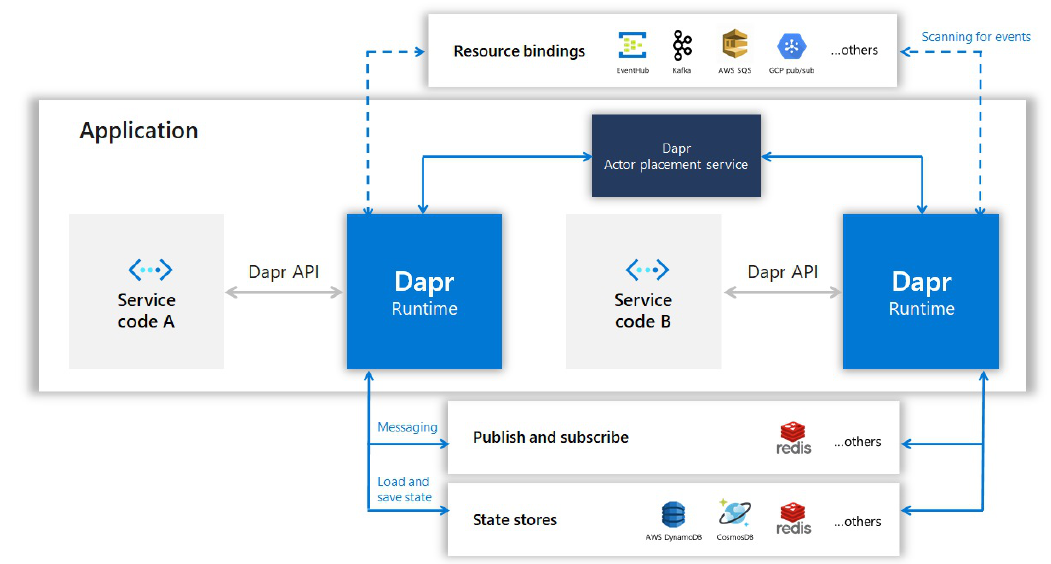
Fig. 4 Data and actor binding.